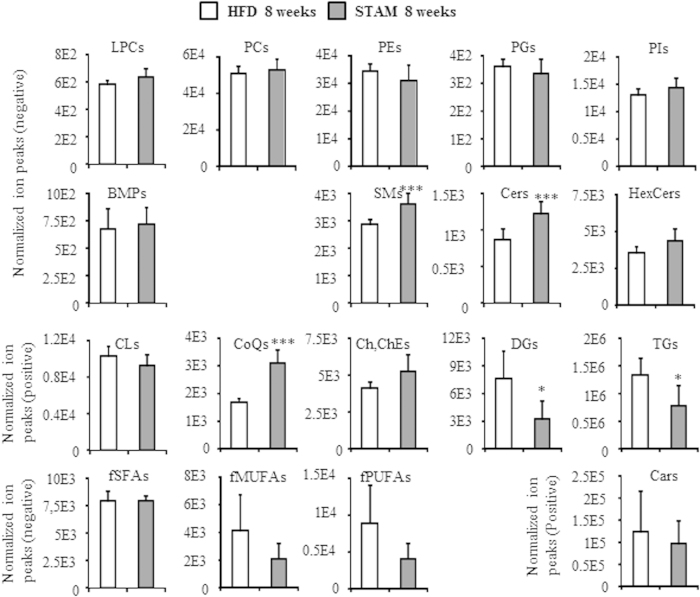
Global abundance of hepatic lipid classes in STAM and control HFD mice at 8 weeks.Lipid extracts were prepared from mouse livers as described in Materials and Methods, and abundance of lipid molecules was measured individually. Data are sum of ion peak heights of all lipid molecules within each class and shown as mean ± SD (n = 5 in each group). *p < 0.05; ***p < 0.005 in statistical tests comparing control HFD mice and STAM mice. LPCs, lysophosphatidylcholines; PCs, phosphatidylcholines; PEs, phosphatidylethanolamines; PGs, phosphatidylglycerols; PIs, phosphatidylinositols; BMPs, bis(monoacylglycerol)phosphates; SMs, sphingomyelins; Cers, ceramides; HexCers, hexosylceramides; CLs, cardiolipins; CoQs, coenzyme Qs; Ch/ChEs, cholesterol and cholesterolesters; DGs, diacylglycerols; TGs, triacylglycerols; fSFAs, free saturated fatty acids; fMUFAs, free monounsaturated fatty acids; fPUFAs, free polyunsaturated fatty acids; Cars, acylcarnitines.